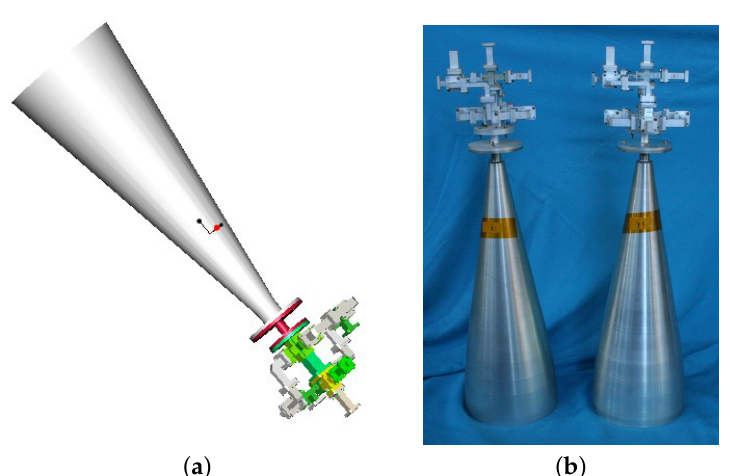
Figure 2. MWR antenna design with prototype. ( a ) MWR antenna design. ( b ) Prototype of MWR antennas for satellites A and B.